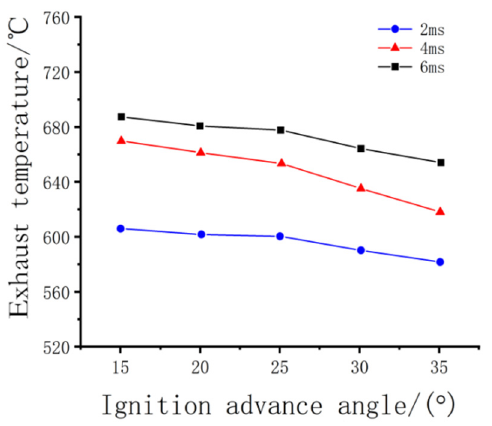
Figure 21. Influence of the ignition parameters on exhaust temperature.